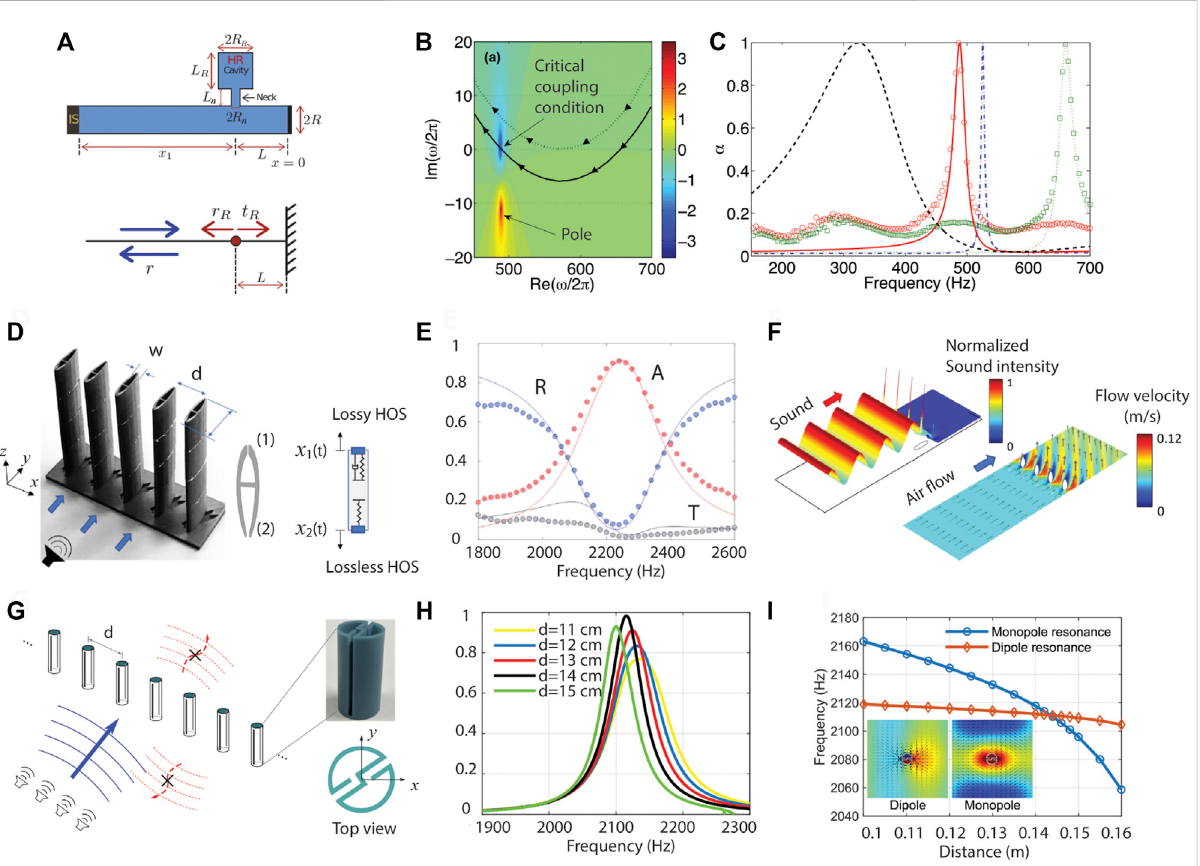
FIGURE 6 Critical coupling for perfect sound absorption. (A) Coupled resonator in a one-port system. (B) Critical coupling conditon. (C) Perfect sound absorption of the resonator system (A) . (D) Coupled resonators composed of loss/lossless in a two-port system. (E) Corresponding absorption spectra. (F) Sound absorption and fl uid- fl ow (ventilation) control. (G) Coupled resonators consisting of loss/loss in two-port system. (H) Absorption spectra for different period. (I) Monopole and dipole resonance enabled by a certain period (d = 0.14 m). Reprint (A – C) from Ref. [49]; (D – F) from Ref. [47]; (G – I) from Ref.